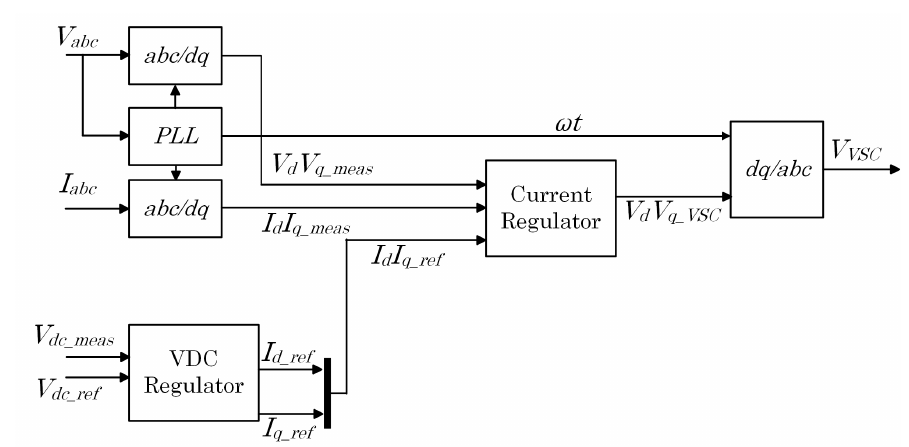
Figure 5. Diagram of voltage source converter (VSC)